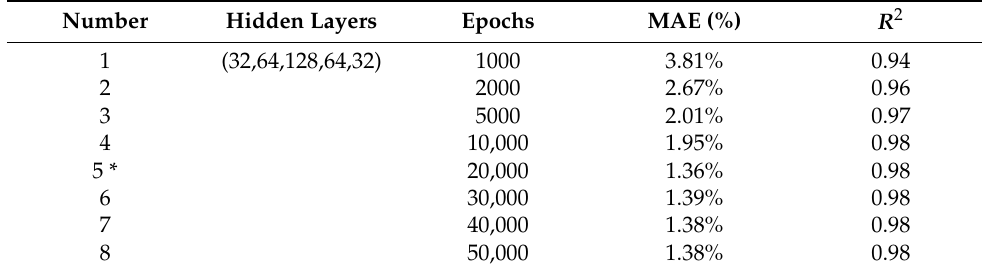
Table 5. Study of epochs and their effect on results.